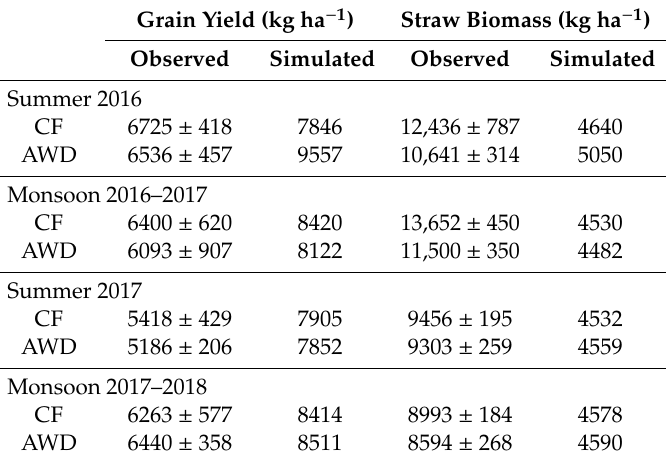
Table 2. Observed and simulated grain yield and straw biomass under continuous flooding (CF) and alternate wetting and drying (AWD) conditions during di ff erent rice-growing seasons. Observed values represent the means ± standard deviation ( n =